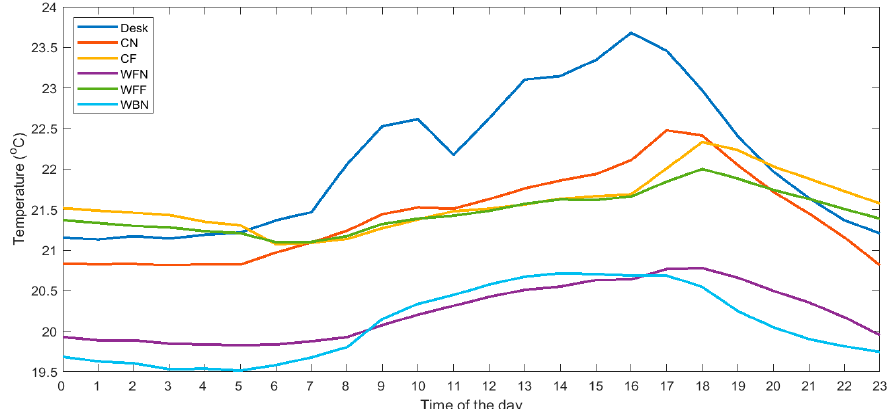
Figure 8. Time series of temperature sensors with various positionings.